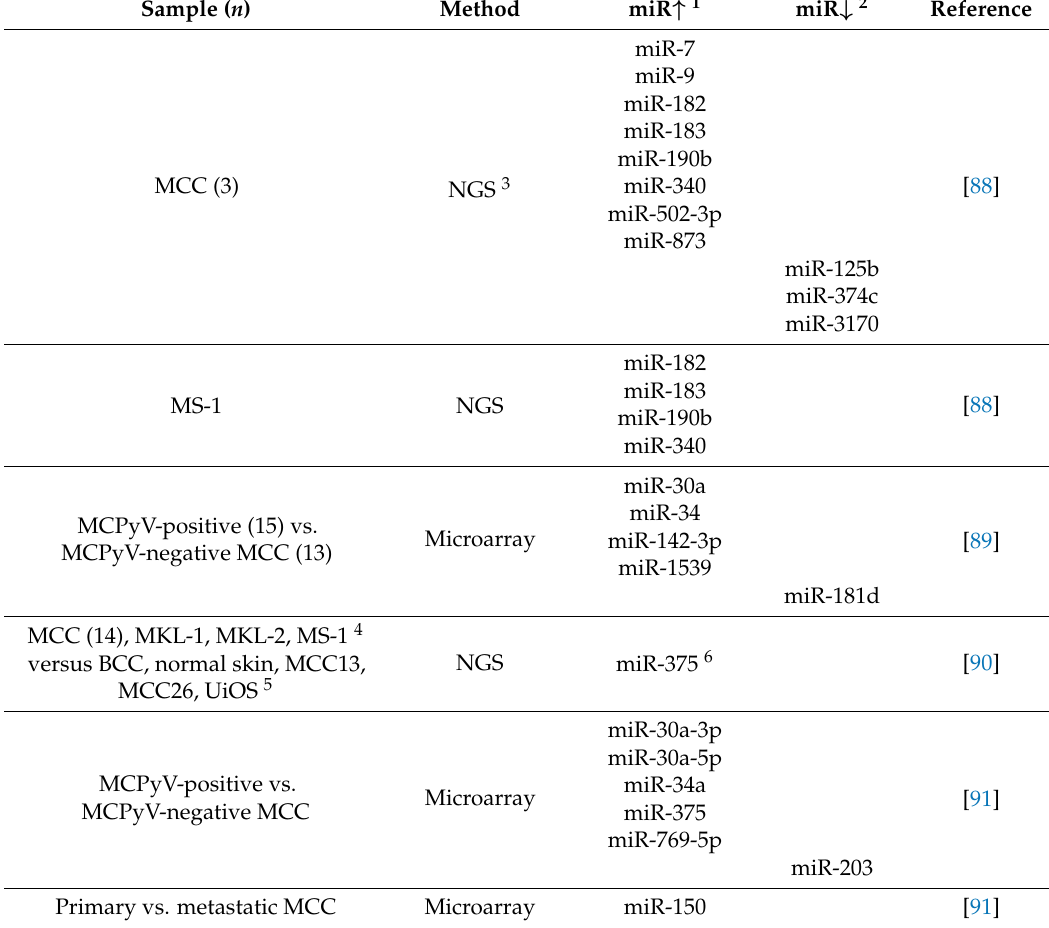
Table 1. Differential expressed miRNAs in MCC or MCC-derived cell lines. See the text for